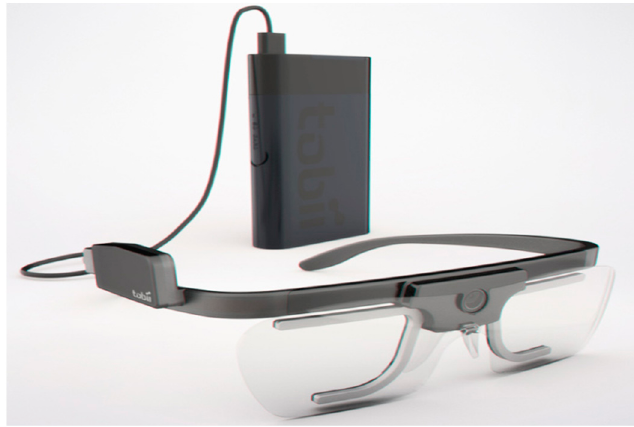
Figure 1. Tobii Pro Glasses 2 used as the eye tracker in this study [27].